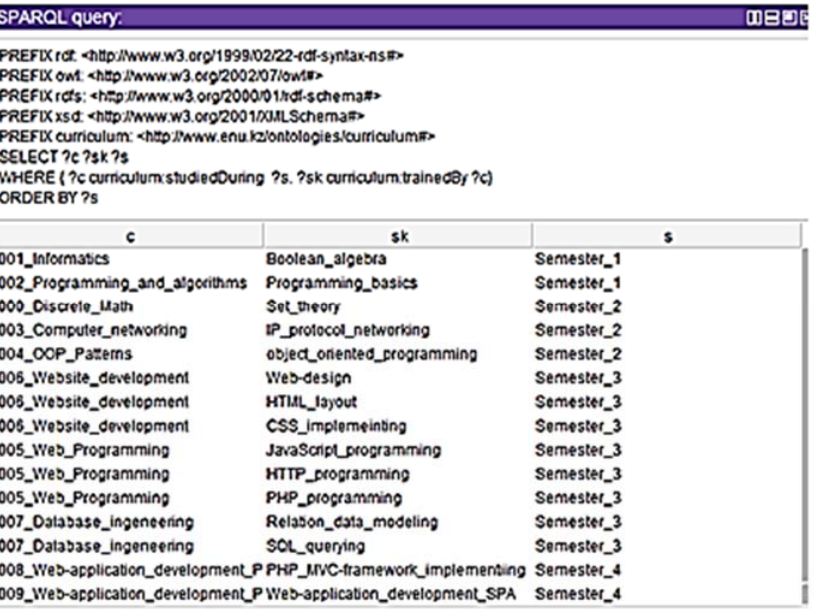
Figure 14. Skills formed by the courses of the curriculum with the indication of the semester.